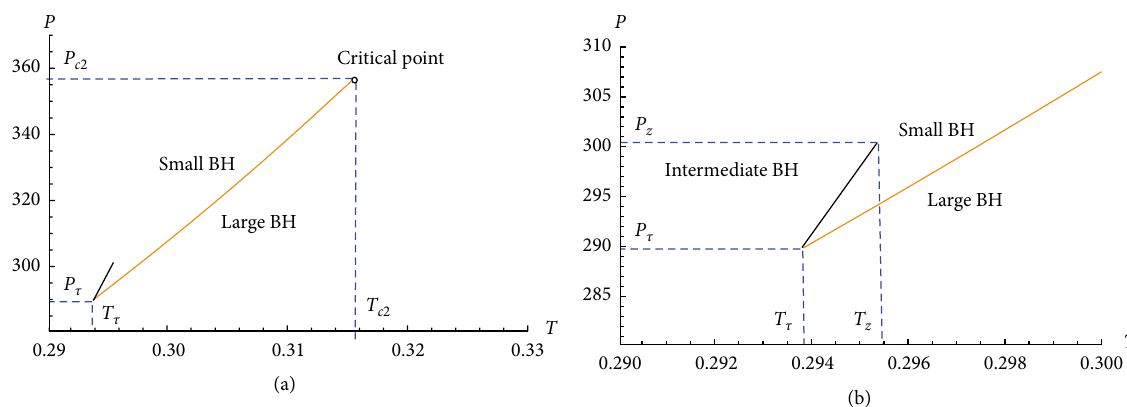
= 0.1113 . The thick 𝑝